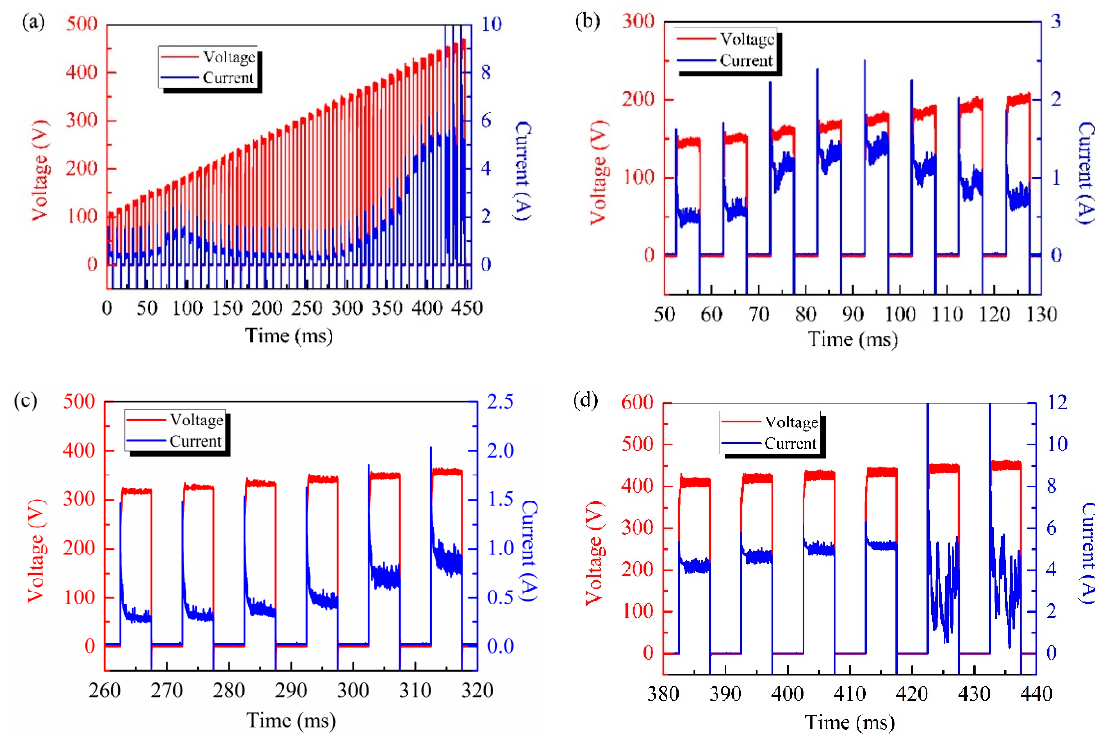
Figure 2. ( a ) Voltage and current waveforms of the initial test pulses and ( b – d ) partial waveforms.